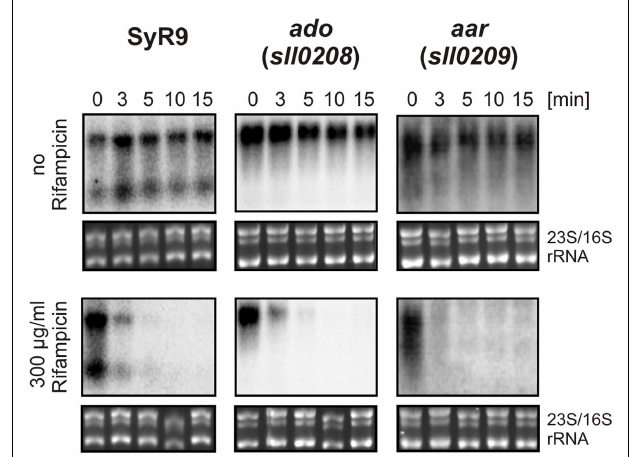
FIGURE 5 | RNA stability measurements . Half-lives of the indicated transcripts were determined in the presence of rifampicin in cultures for the times indicated. For comparison, samples were taken at the identical time points but in the absence of rifampicin. For the control of equal loading, the large rRNA bands stained with ethidium bromide are shown underneath each